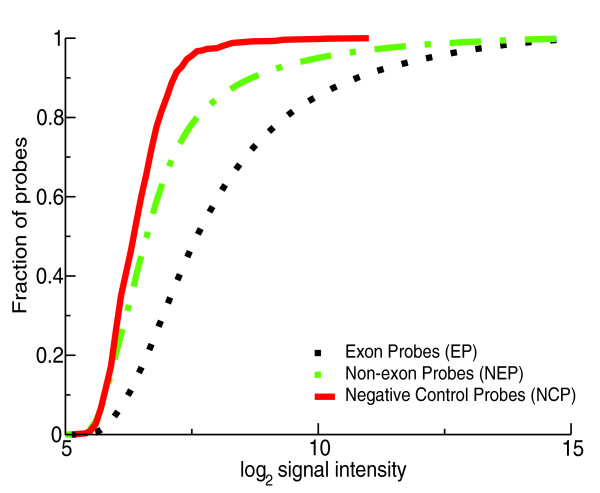
Signal intensity distributions of probes measuring annotated A. gambiae exons (EPs), non-exon regions (NEPs) and negative controls (NCPs). Cumulative distribution functions of signal intensities for these probe populations are shown for a representative channel.